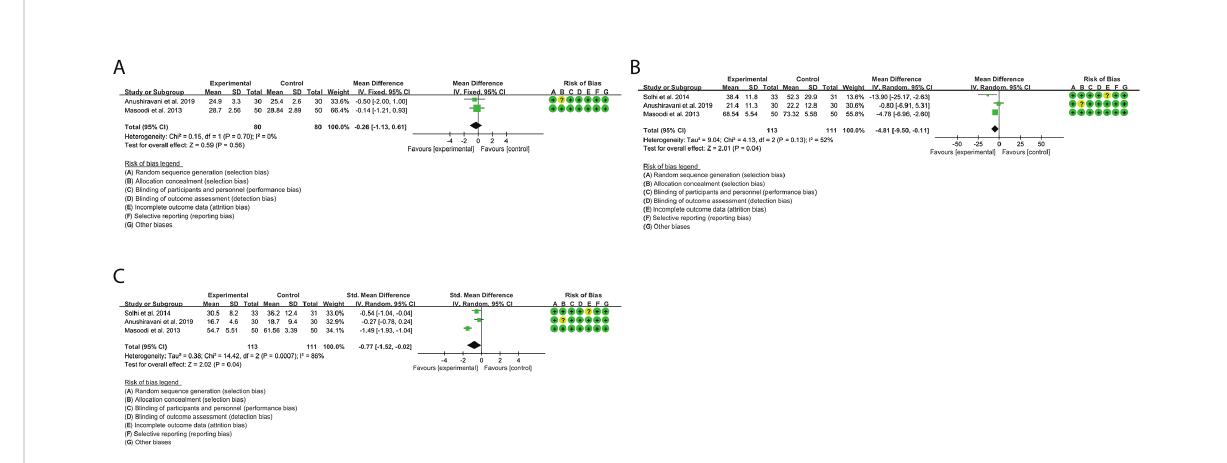
FIGURE 6 Outcomes in silymarin treatment ( A : BMI; B : ALT; C :